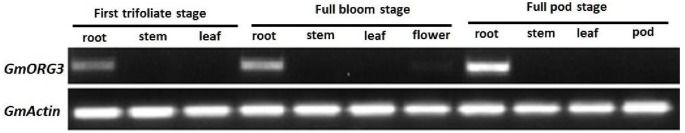
Transcript abundance of GmORG3 in the roots, stems, leaves, flowers, and pods of soybean at the first-trifoliate, full-bloom and full-pod stages. The experiments were carried out using semi-quantitative RT-PCR; GmActin was used as an internal control for the normalization of cDNA templates. The PCR was repeated twice, each producing similar results.